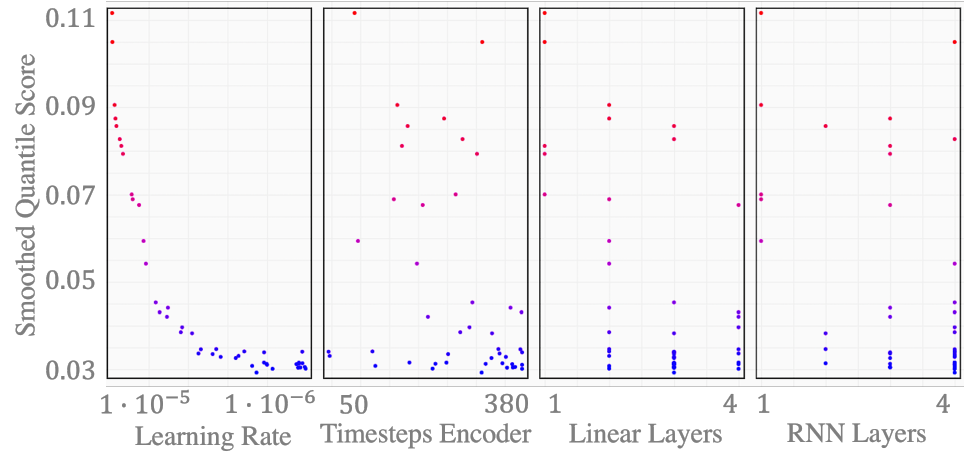
Figure 8. Scatter plot of optimal hyperparameter